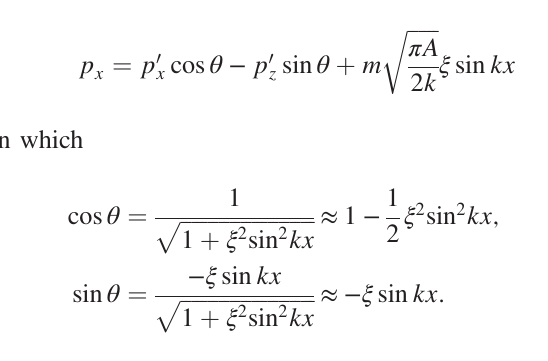
FIG. 4. The schematic plot for the bulk photoemission on a 2D sinusoidal surface. The definitions of coordinates and variables are marked in the